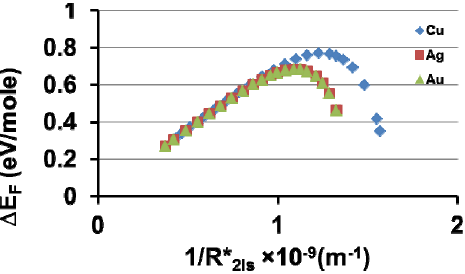
in F in nm − 1 . 2ls